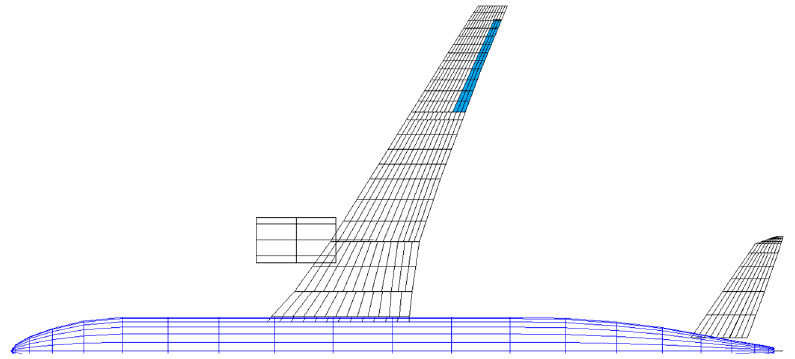
Figure 25. Deflected control surfaces using the simple GLA algorithm.